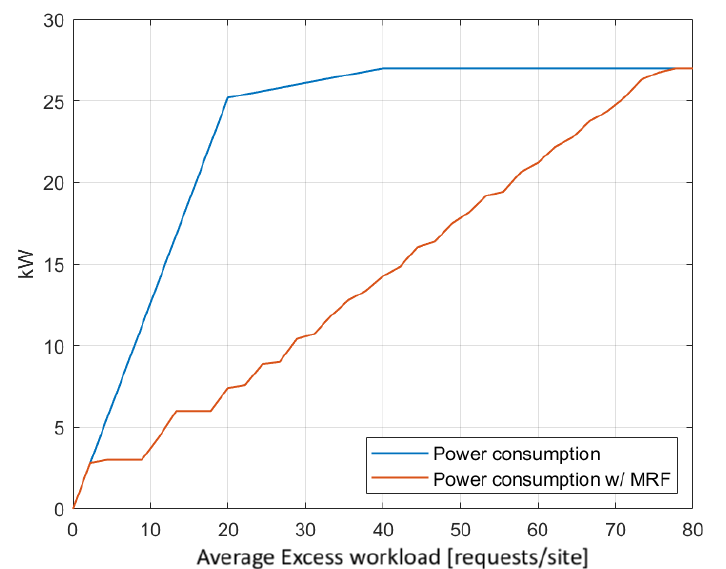
Figure 10. MRF energy savings for various excess workloads in underloaded